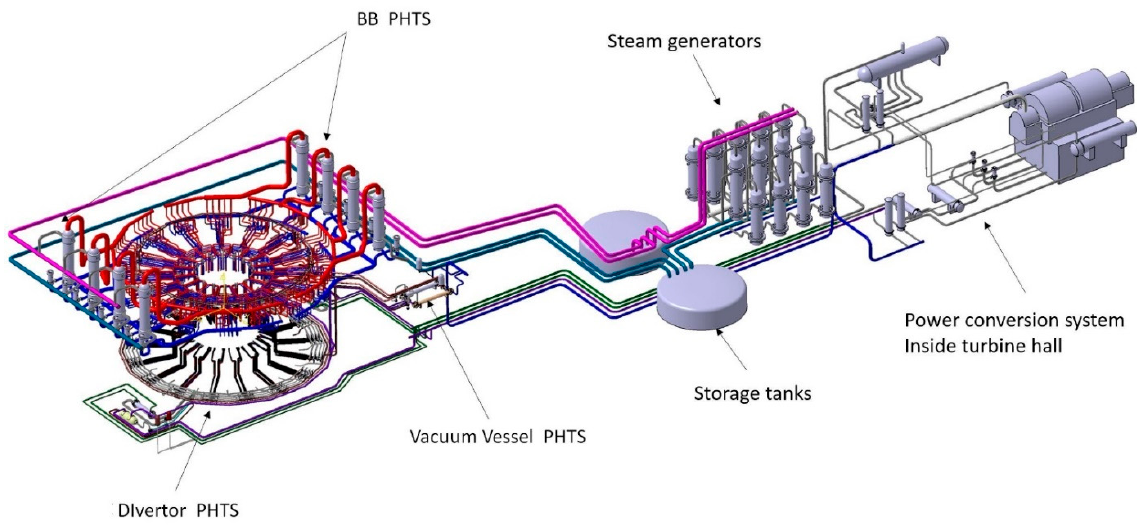
Figure 5. Schematic layout of DEMO HCBP ICD design including all PHTS systems, the IHTS with two tank ESS, and the PCS up to the AC generator.